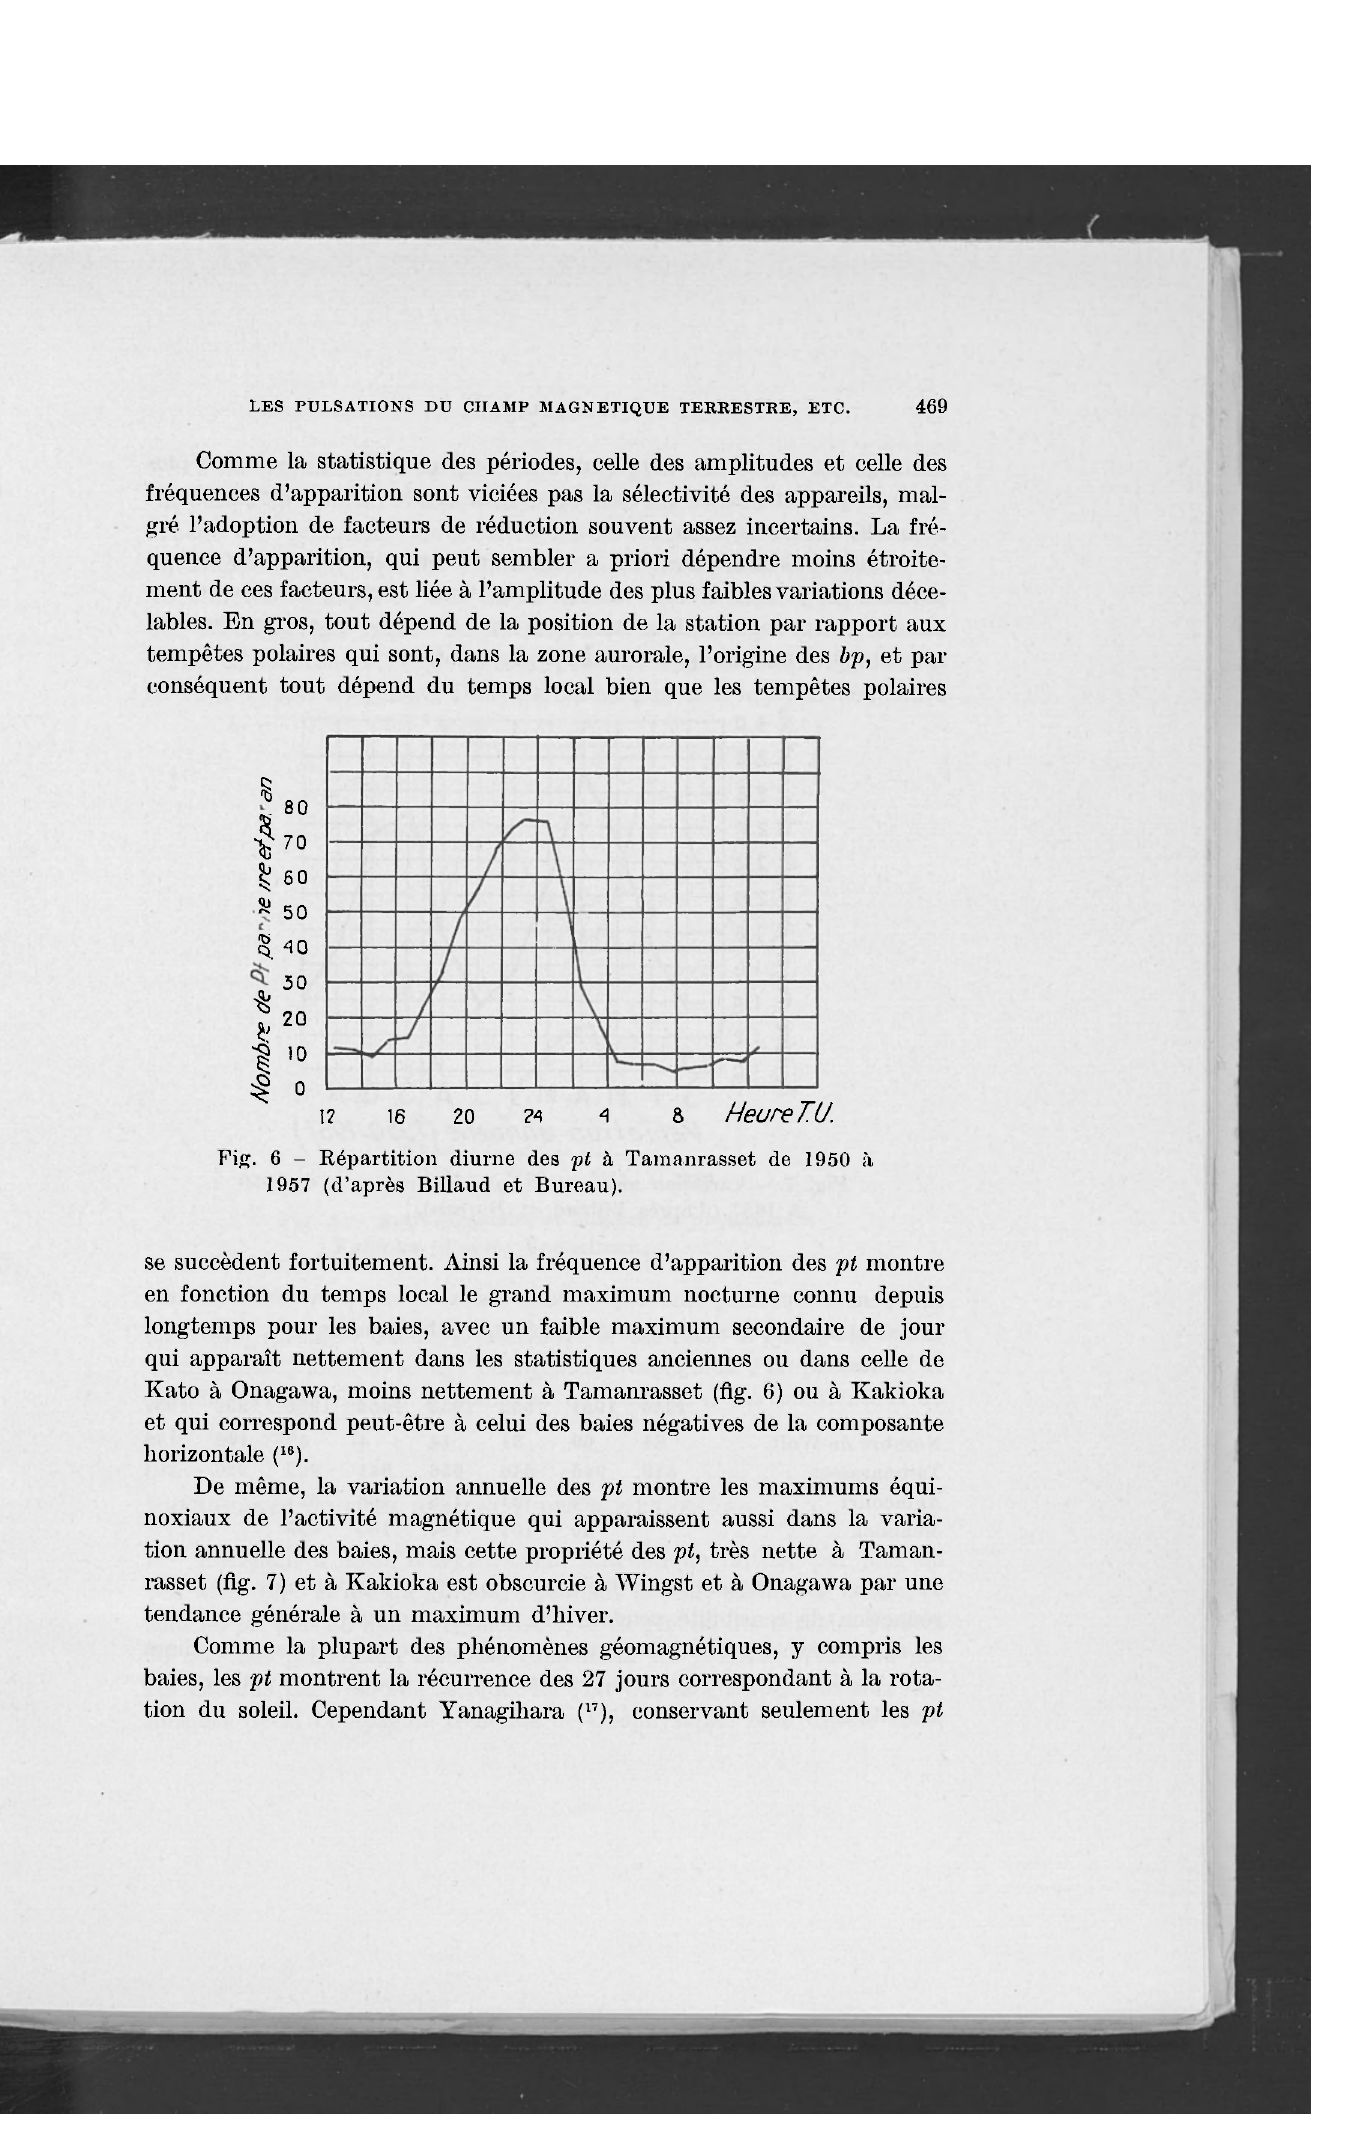
Fig. 6 - Répartition diurne des pt à Tamanrasset de 1950 à 1957 (d'après Billaud et